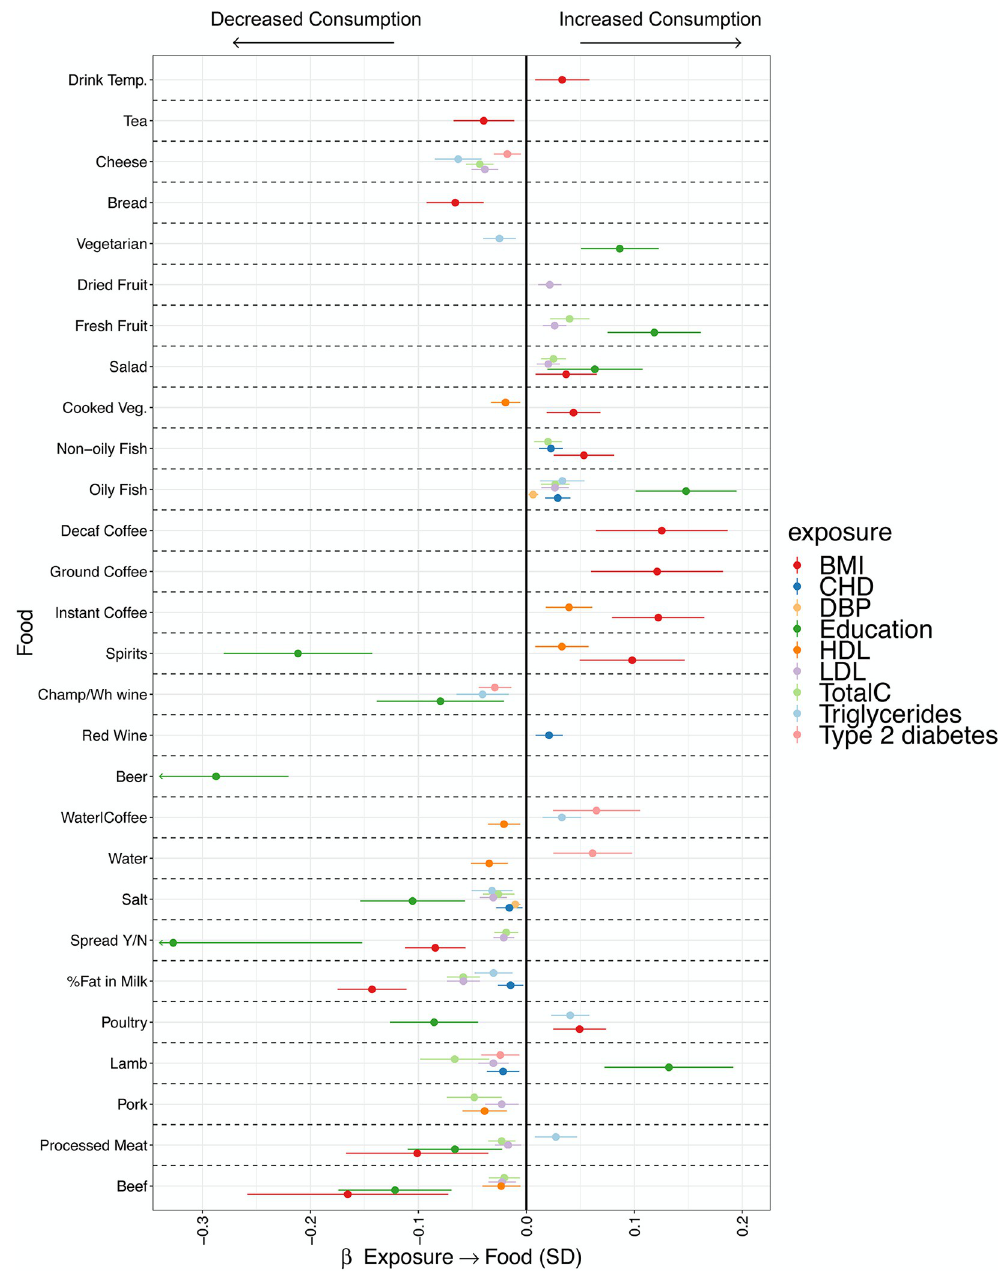
Fig 5. Health status influences reported food choices. The plot reports only the univariable MR results which were significant at FDR < 0.05. For each food outcome the effect estimate ( β ) is reported in standard deviations of the exposure trait, together with 95% confidence intervals. Each colour represents a different exposure. BMI, body mass index; CHD, coronary heart disease; DBP, diastolic blood pressure; HDL, high density lipoprotein cholesterol; LDL, low density lipoprotein cholesterol; TotalC, total cholesterol. Champ/Wh wine, champagne, white wine. Temp,